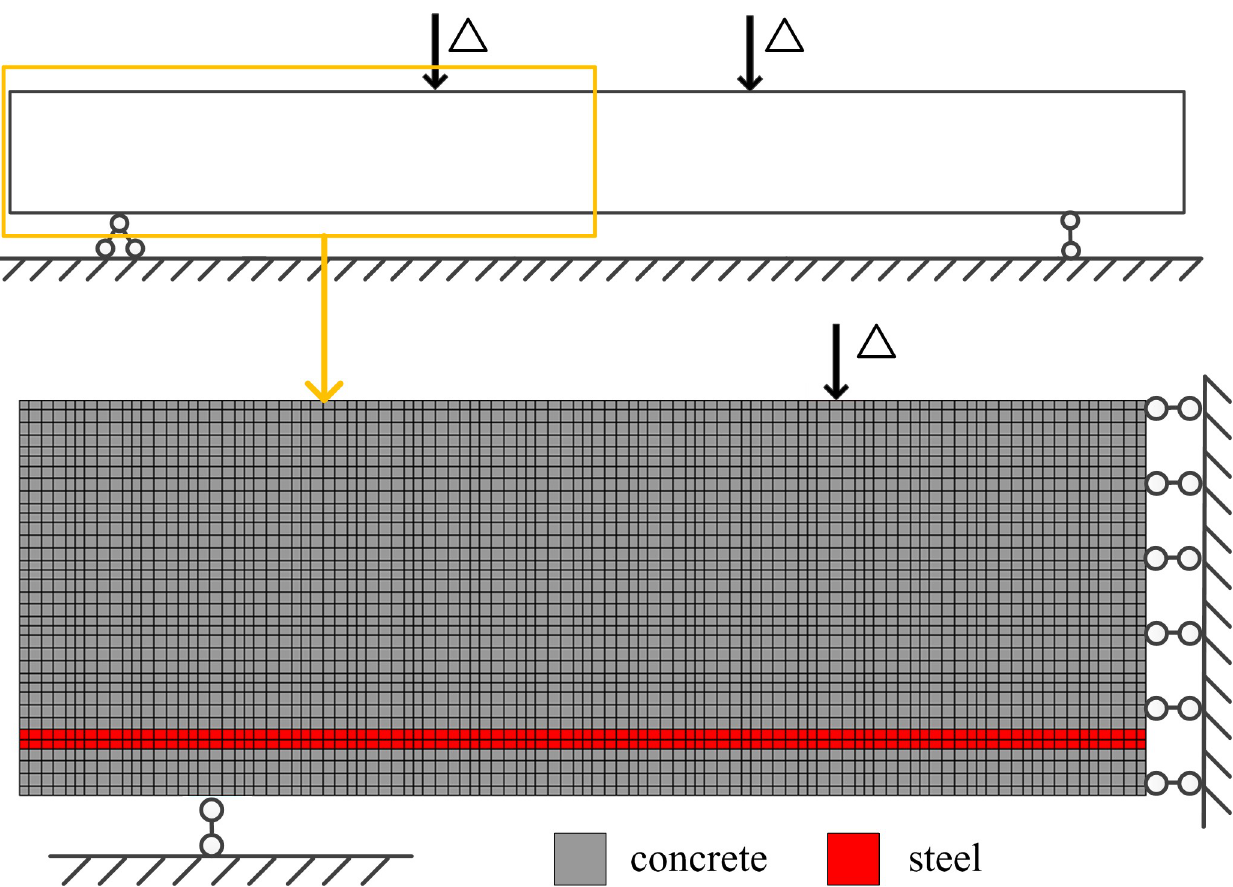
Fig 15. Four-point bending RC beam model. The half of the beam in Fig 14 is modeled because of symmetry. The horizontal displacement of mid-span section of the FE model is constrained to zero.